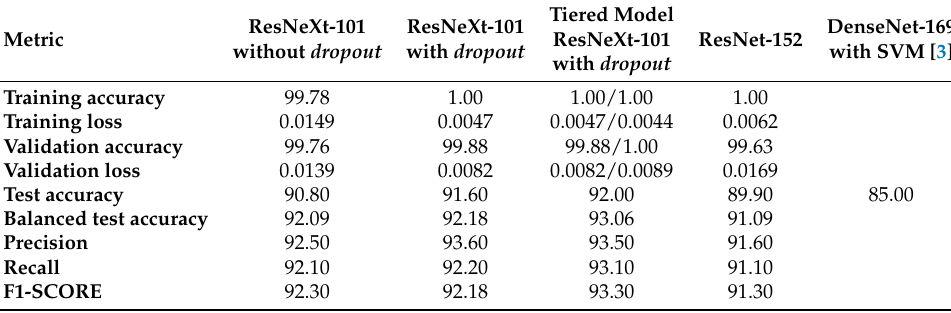
Table 2. Comparison of different classification models (% except for